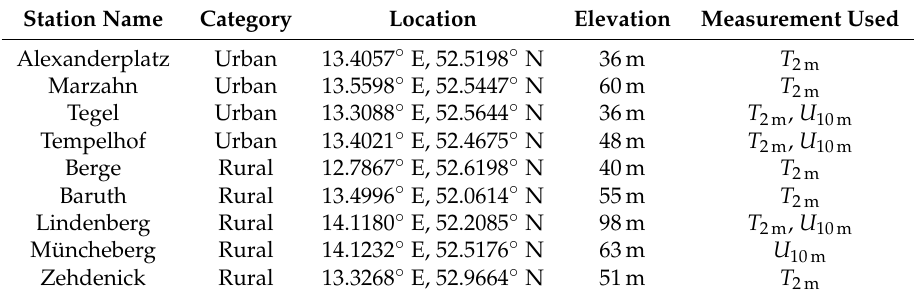
Table 9. Measurement stations used for determining the accuracy of our model setups. The locations of the stations are indicated in the inner nested domain d03 on Figure